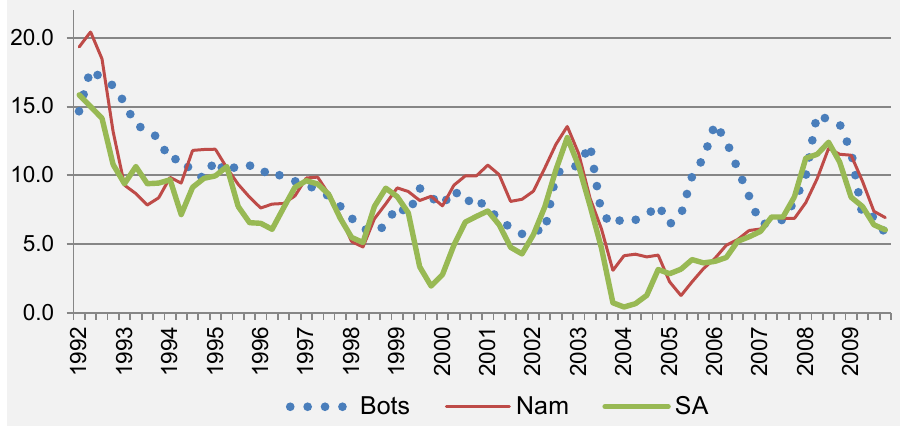
FIGURE 1: Inflation rates Source: BoB, BoN,